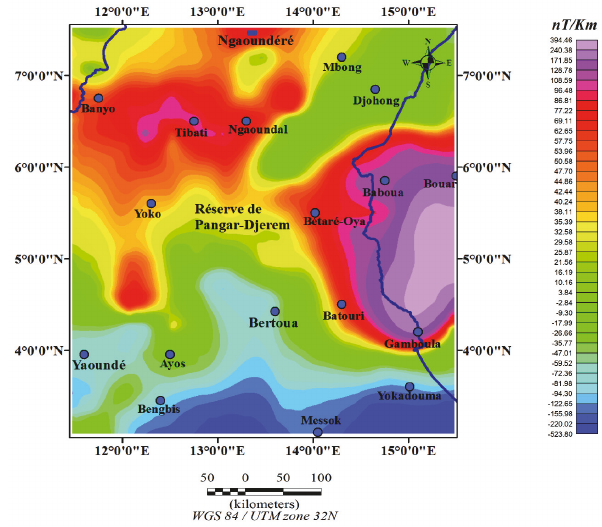
Figure 3: Total magnetic intensity map of the study area